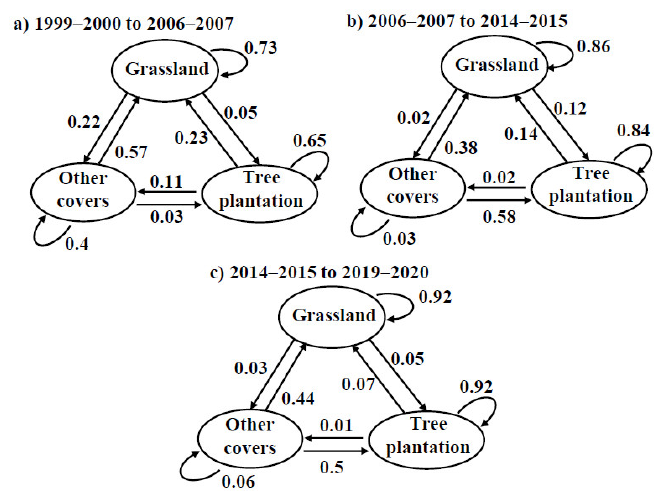
Figure 3. Land covers’ transition probability analysis within the Aguapey VGA between ( a ) 1999–2000